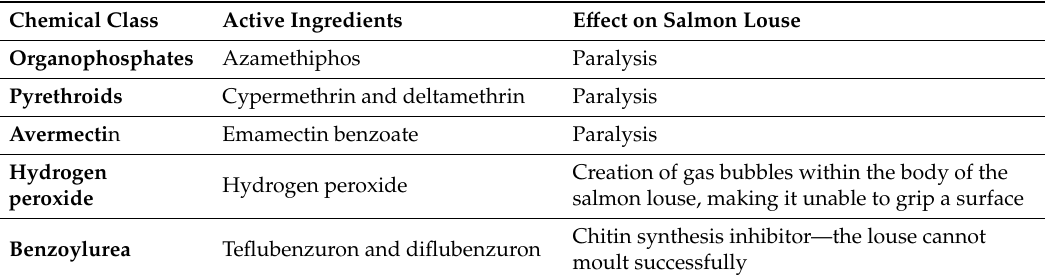
Table 1. Commonly used chemical compounds used to treat salmon louse infestations